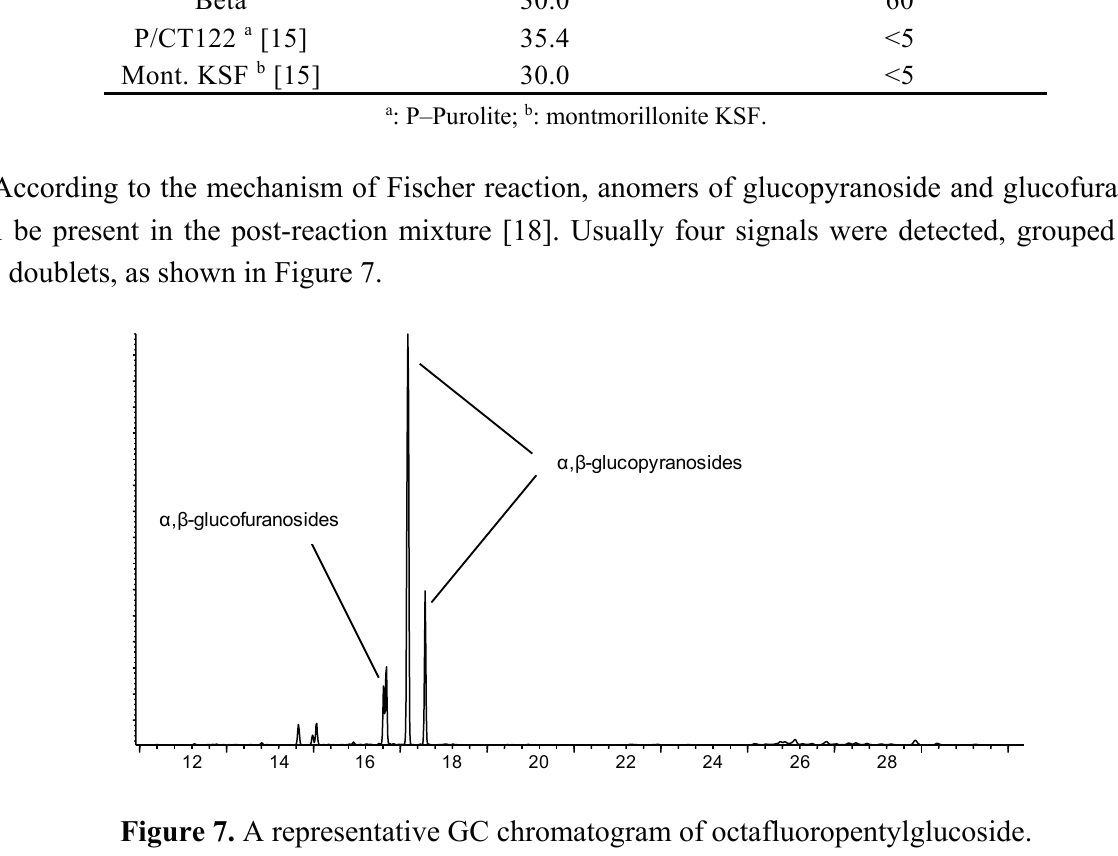
Figure 7. A representative GC chromatogram of